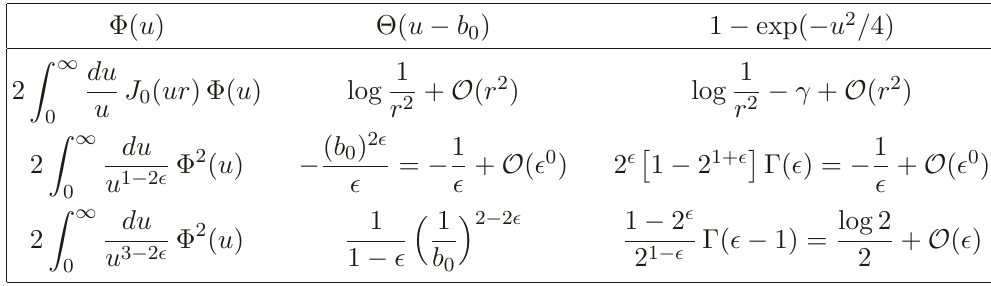
Table 1 . Examples for the cutoff function Φ and relevant integrals. Exact results for the integral in the second row are given in (A.3) and (A.4). The integral in the third row converges for ǫ <